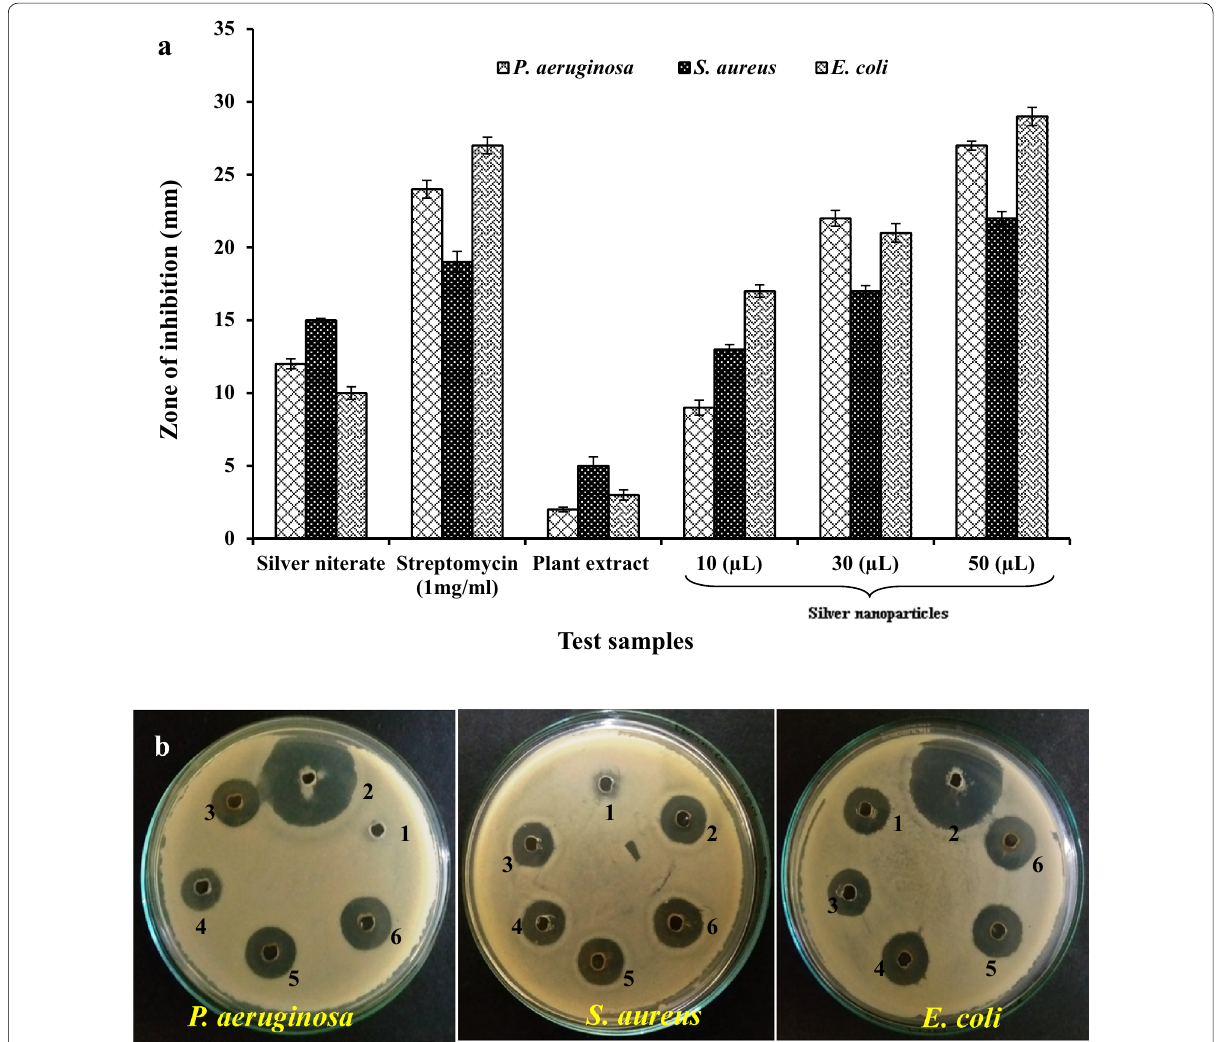
Fig. 7 a Antibacterial activity of silver nanoparticles against various pathogenic bacterial strains. b Zone of inhibition (1) Plant extract; (2) Streptomycin; (3) Silver nitrate; (4) 10 µl silver nanoparticles; (5) 30 µl silver nanoparticles; (6) 50 µl silver